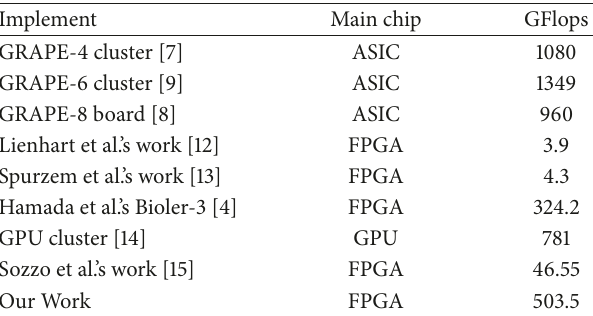
Table 5: Hardware performance